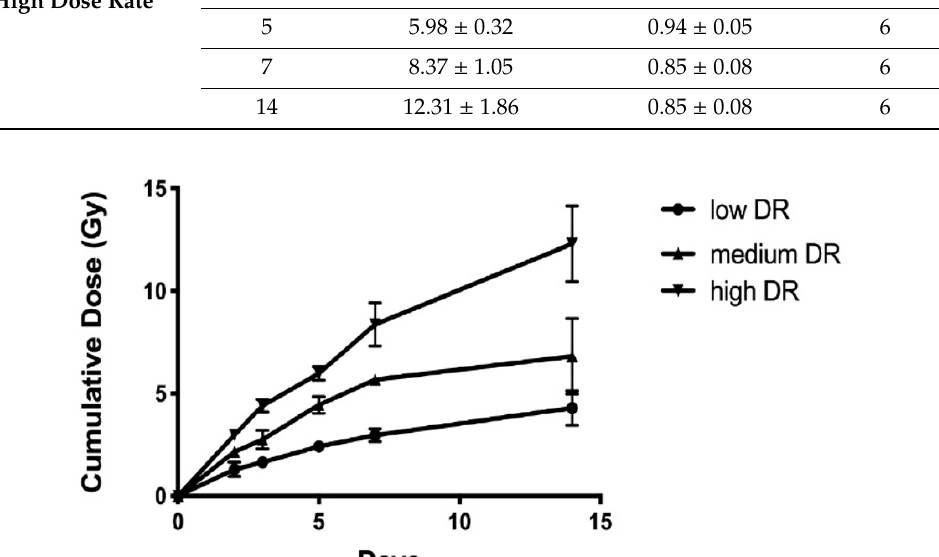
Figure 1. Calculated cumulative dose over the 14-day study period in three dose rate (DR) groups after administration of 137 Cs with various activity.